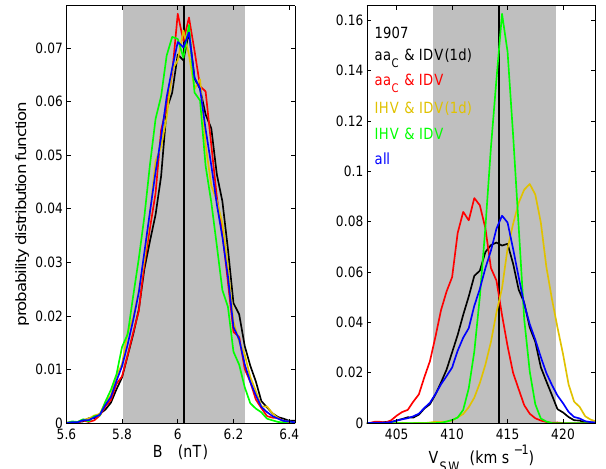
Fig. 7. An example of probability distributions (for the year 1907) generated by application of the Monte Carlo regression techniques used in Paper 2 (Lockwood et al., 2013b) for IMF B (left) and so- lar wind speed V SW (right). The fits minimise the normalised rms deviation of the fits from the data on both IMF, B , and solar wind speed, V SW . A total of 10000 fits for each pairing of geomagnetic activity indices were carried out, with random errors added (drawn from measured distributions). The resulting distributions are shown for aa C and IDV(1d) (black), aa C and IDV (red), IHV and IDV(1d) (orange), and IHV and IDV (green). The blue probability distribu- tion function is the sum of these four for which the grey band shows the 2 σ points (between which are 95% of values) and the black vertical line shows the